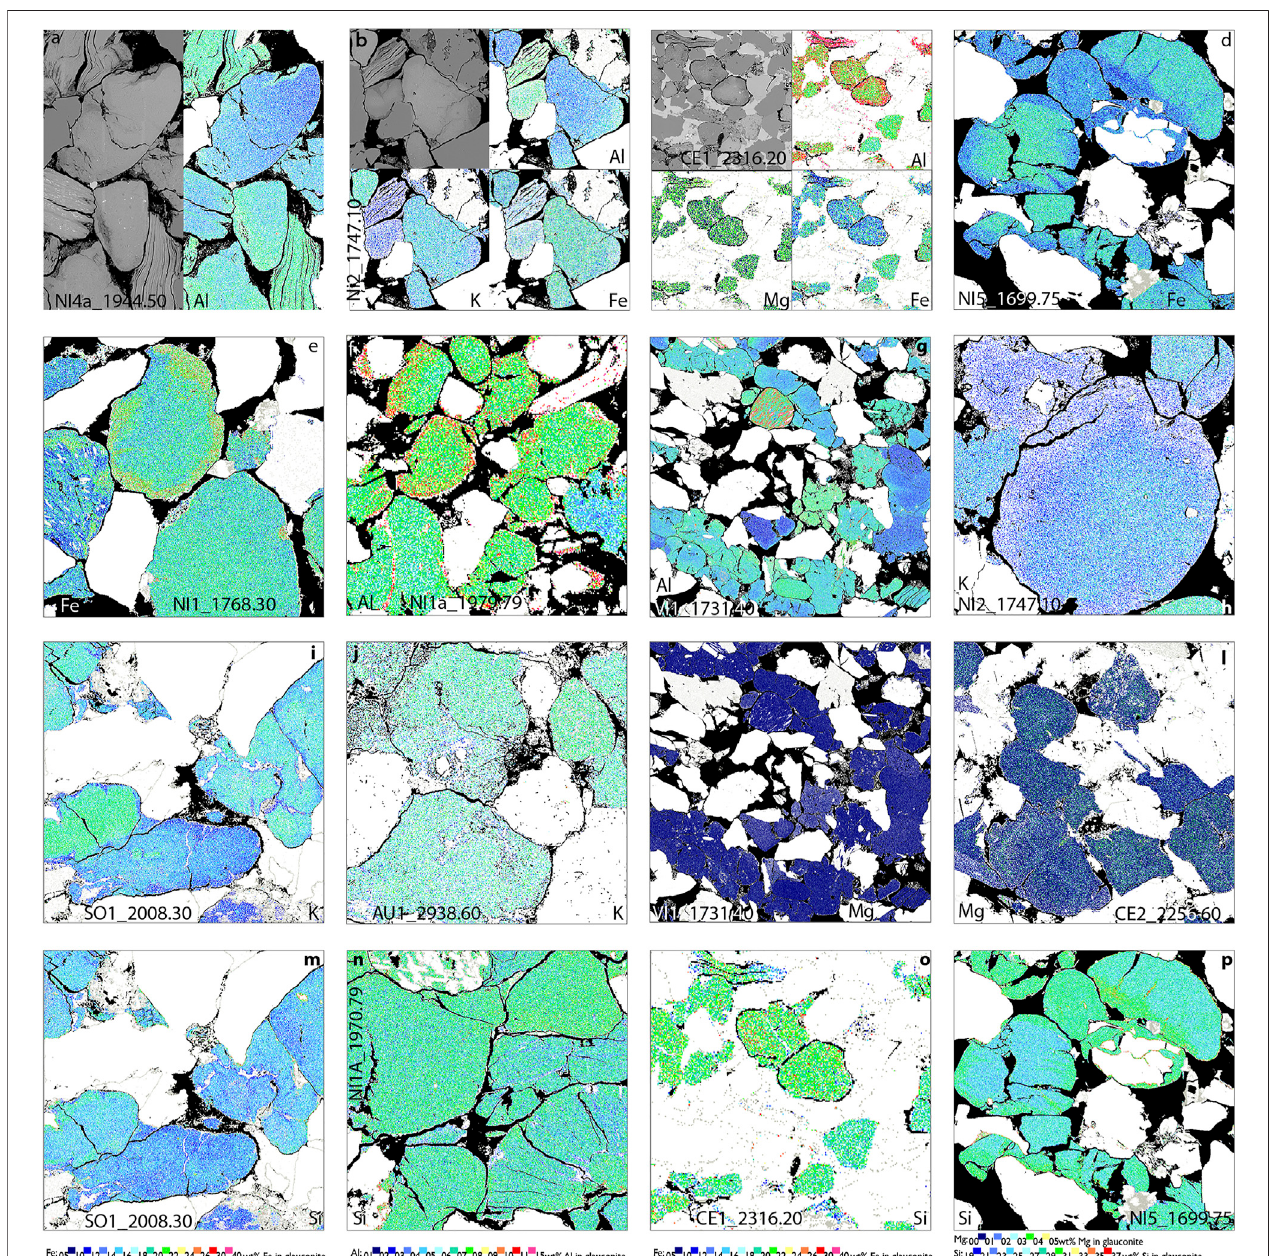
FIGURE 3 | Details of glauconitic clasts ’ cores, rims and fractures from the Siri Canyon. See text for details. Grey-scale images are BSE micrographs.